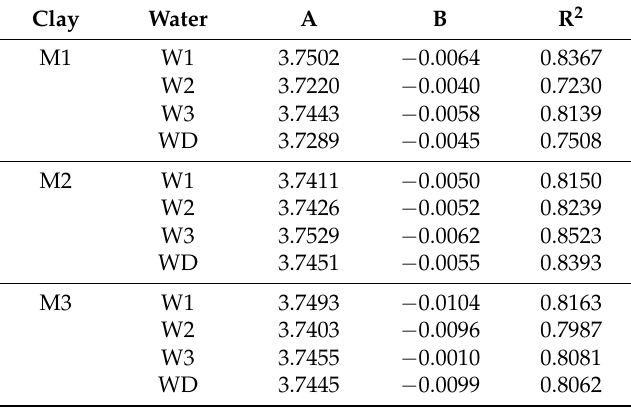
Table 8. The intercept (A), slope (B) and determination coefficients (R 2 ) of the regression lines by types of clay and water.